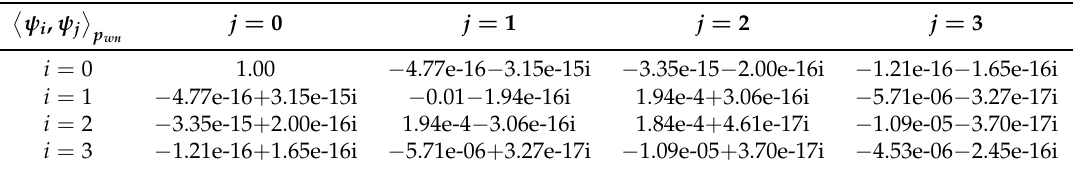
Table 3. Rogers-Szeg˝o Inner